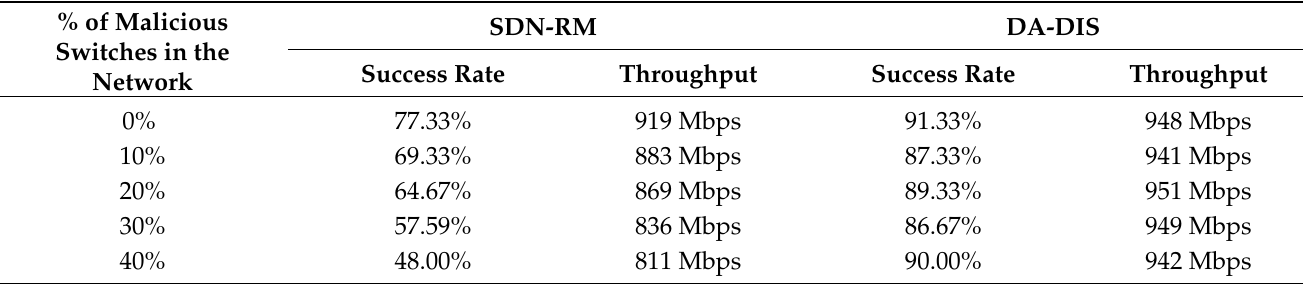
Figure 14. Throughput considering different numbers of malicious switches with E2 category faults. Table 3. Results overview of Case